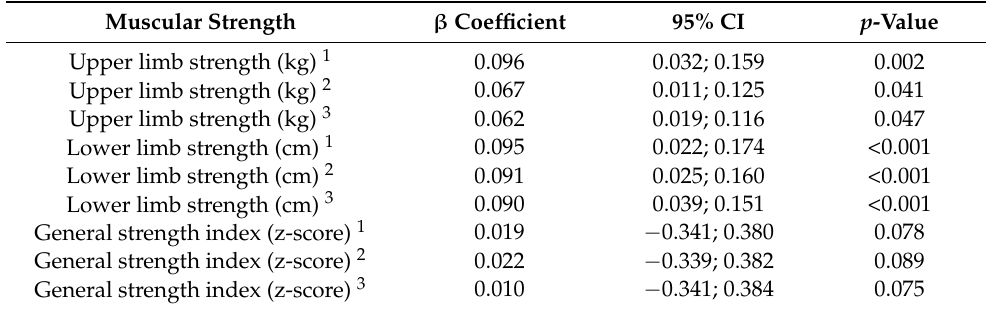
Table 3. Adjusted analyses between the muscular strength of upper and lower limbs and self-esteem in 9-year old Chilean boys: independent associations with body composition indicators. Muscular Strength β Coefficient 95% CI p -Value